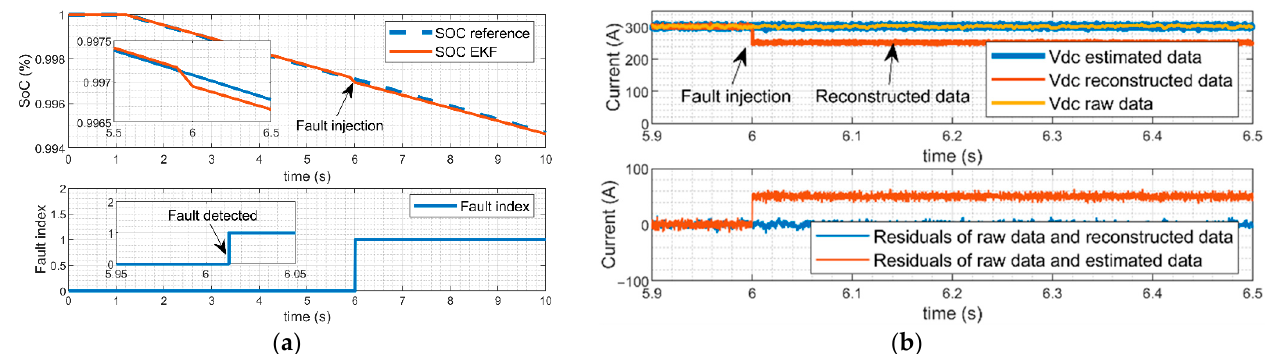
Figure 16. System response of battery cell voltage sensor fault. ( a ) Estimated and reference values of SoC; ( b ) DC bus voltage signal and its residual.